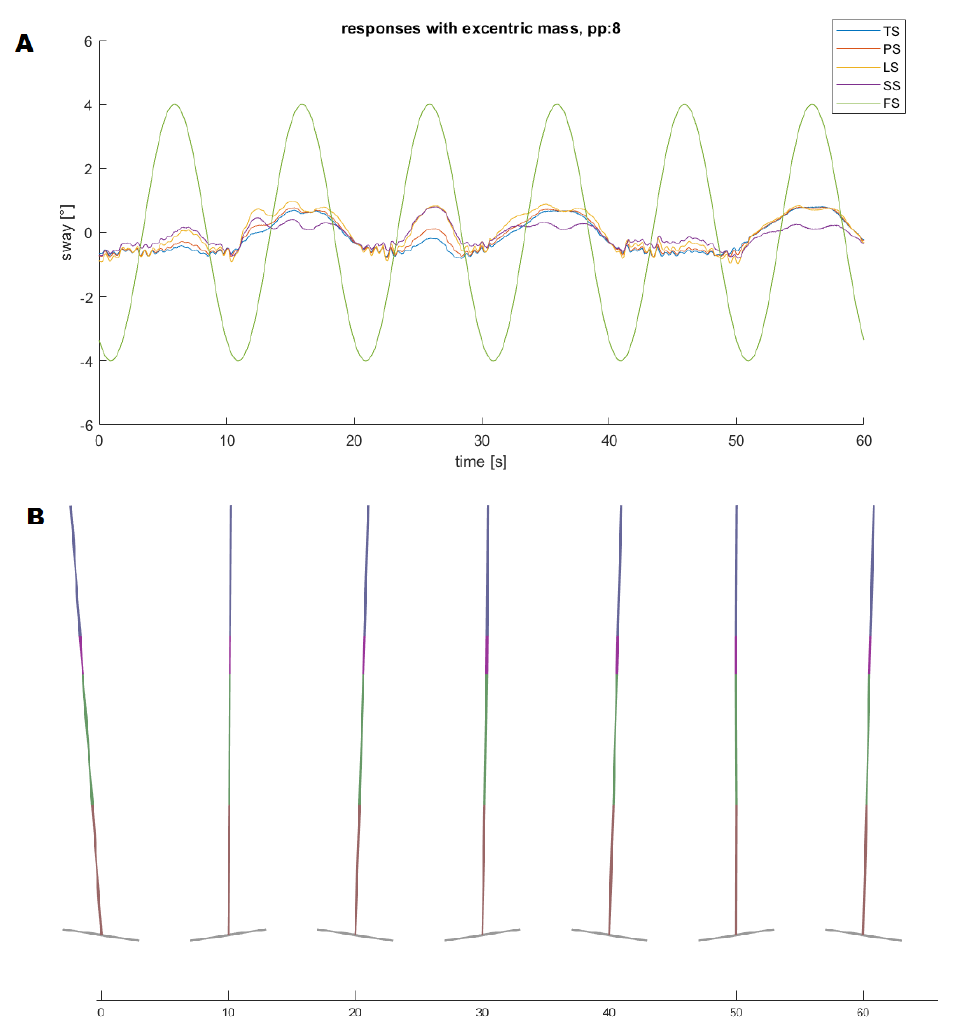
sensors in the presence of a peak-to-peak 8 ◦ tilt and with the addition of an eccentric weight to the pelvis (compare Figure 2A). TS—trunk-in-space; PS—pelvis-in-space; LS—leg-in-space; SS—shank-in-space; FS—foot in space. All body segments move together in this scenario, and all sways are within a range smaller than 1 ◦ ; ( B ) stick figure showing the position of the segments at di ff erent times (every 10